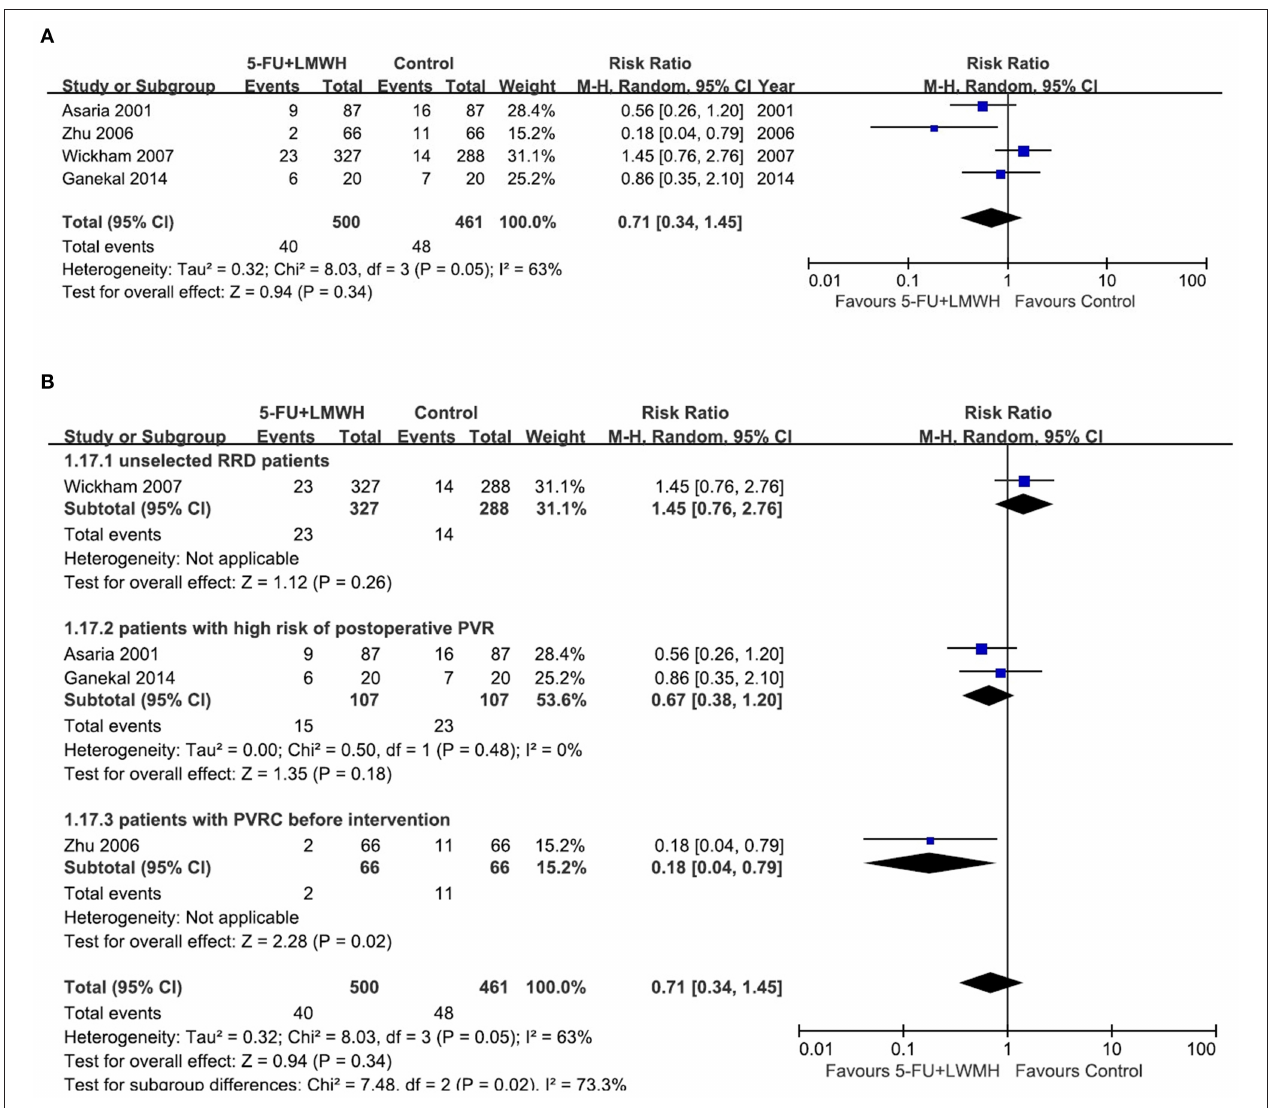
FIGURE 7 | Forest plots for the meta-analysis of the number of vitreoretinal reoperations due to postoperative PVR. (A) Overall meta-analysis; (B) Subgroup analysis according to preoperative PVRC